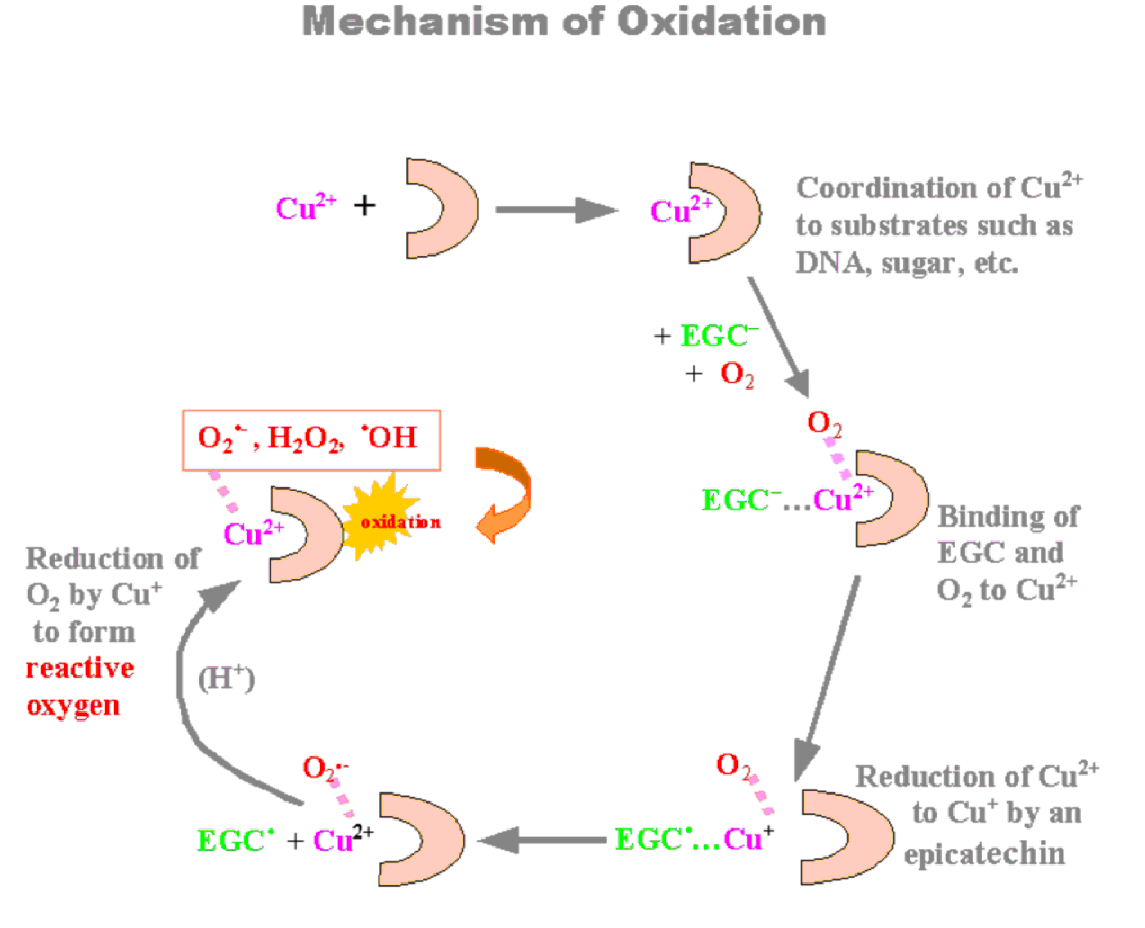
Fig. 7 The mechanism of substrate oxidation by epicatechins and